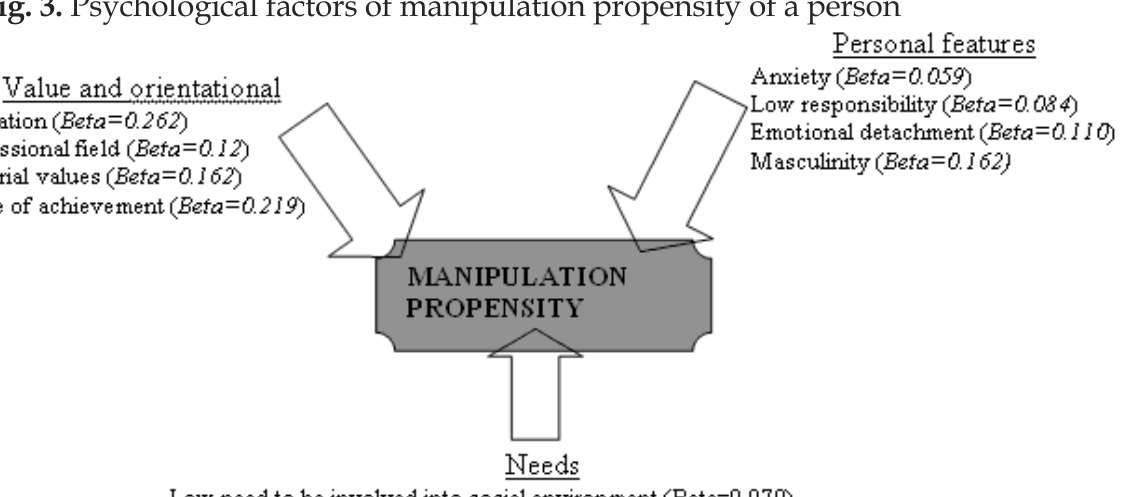
Fig. 3. Psychological factors of manipulation propensity of a person